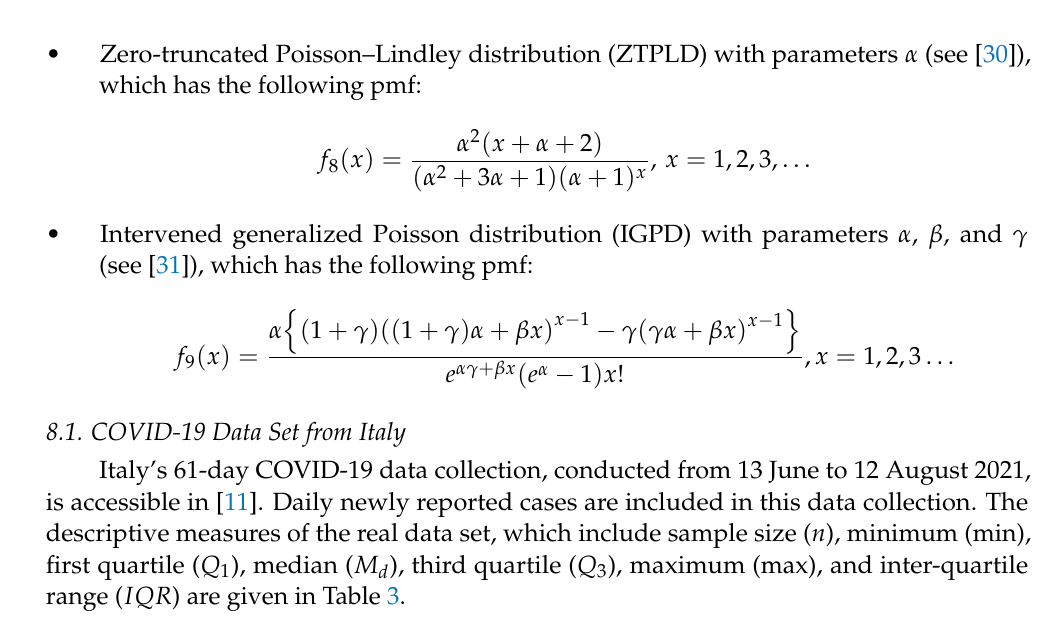
Table 3. Descriptive statistics for the COVID-19 data set of Italy.